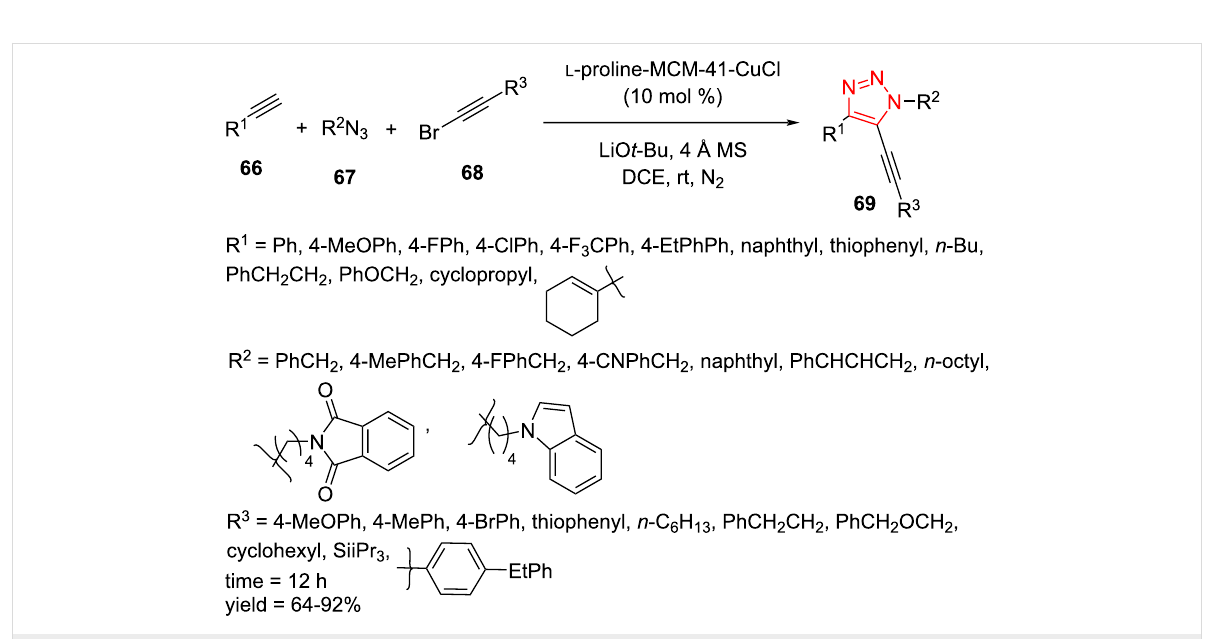
A tandem Click/intramolecular sulfenylation procedure for